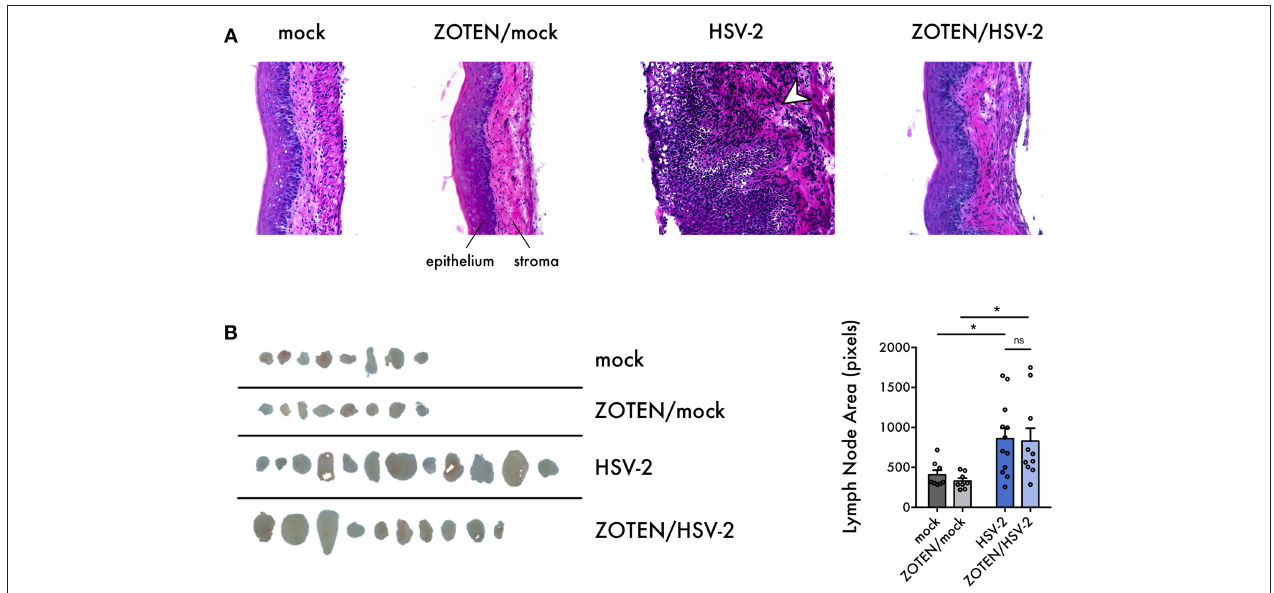
FIGURE 3 | Histological characterization of HSV-2 infection and ZOTEN treatment. (A) Representative images of hematoxylin and eosin stained vaginal tissue sections harvested from mice at 7 days post infection. Tissue epithelium and stroma are indicated. Arrowhead in HSV-2 panel indicates tissue infiltration and inflammation observed in infection. Images taken at 20X magnification. (B) Draining lymph nodes extracted at 7 days post infection. Areas of lymph nodes in pixels are quantified for each group at right. Error bars indicate SEM. Asterisks denote significant difference by two-tailed unpaired Student’s t -test, * p < 0.05, ns, or unlabeled, not